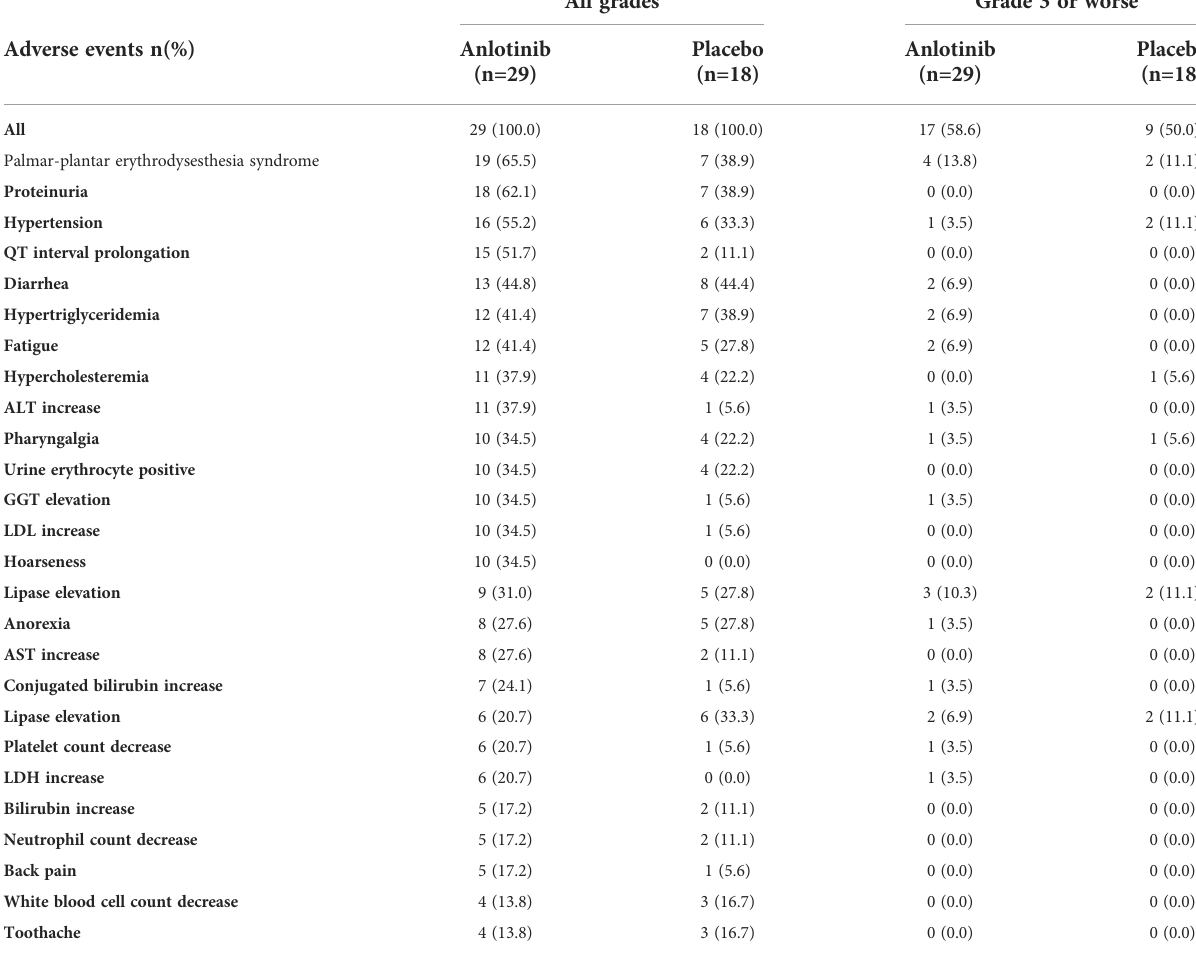
TABLE 3 Common treatment-related adverse events ( ≥ 20%) occurred in patients with bone